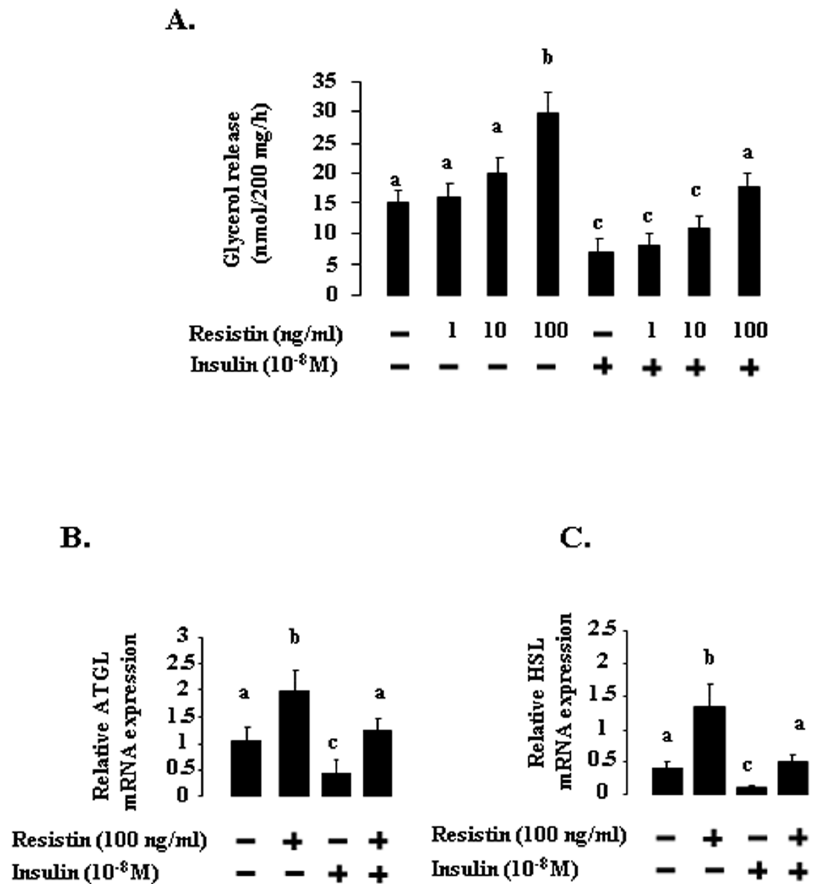
Figure 7. A. Effect of recombinant bovine resistin, in the presence or absence of insulin, on the release of glycerol from subcutaneous adipose tissue explants ( n =4 experiments). Data are expressed as nanomoles of glycerol per 200 milligrams of tissue per 1 h. Each value is the mean 6 SEM, and different letters indicate significant differences at the P , 0.05 level. B. ATGL mRNA and C. HSL mRNA in subcutaneous adipose tissue explants incubated in the presence or absence of recombinant bovine resistin (100 ng/ml) 6 insulin (10-8M) ( n =4 experiments). Relative expression was measured relatively to the geometric mean of 4 reference gene expression [cyclophilin A (PPIA), GAPDH, Actin B (ACTB), and ribosomal protein L19 (RPL19)] by real-time reverse-transcription PCR. Data are presented as means 6 SEM. Different letters indicate significant differences at the P , 0.05 level.